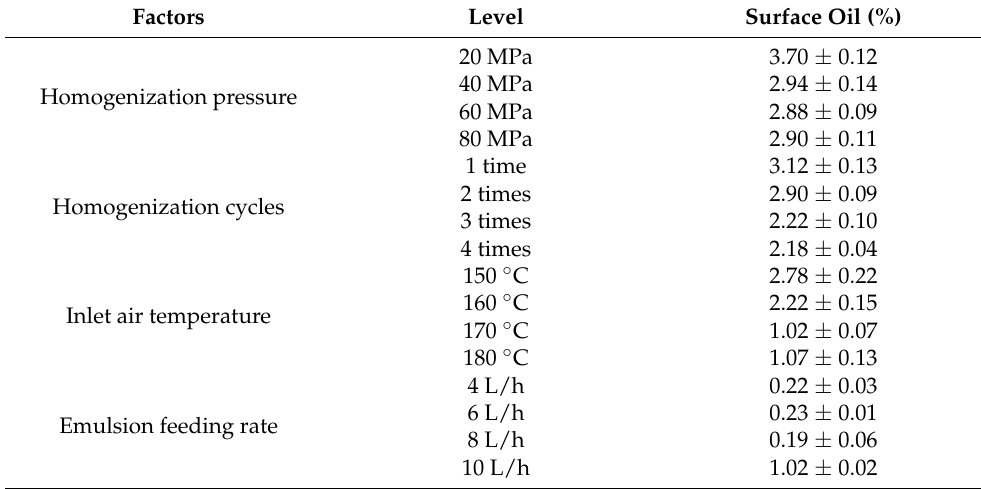
Table 3. Effects of homogenization pressure, homogenization times, inlet air temperature, and emulsion feeding rate on surface oil contents of flaxseed oil